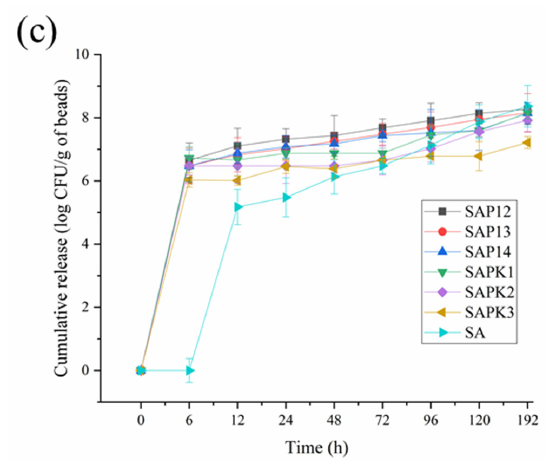
Figure 9. Release profiles of the spores from the studied beads ( a ) at 25 ◦ C, ( b ) at 30 ◦ C, and ( c ) at 35 ◦ C.